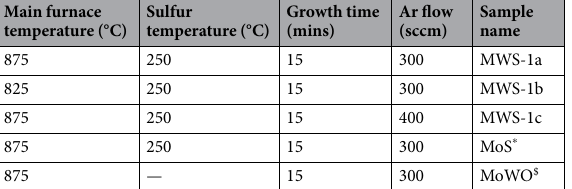
Table 1. Parameters used for the preparation of MWS-1 samples are given here. * No WO 3 is used, only sulfurization of graphene/Mo-TEM grid was carried out. $ No sulfur is used. Only WO 3 was heated over which graphene/Mo-TEM grid placed face